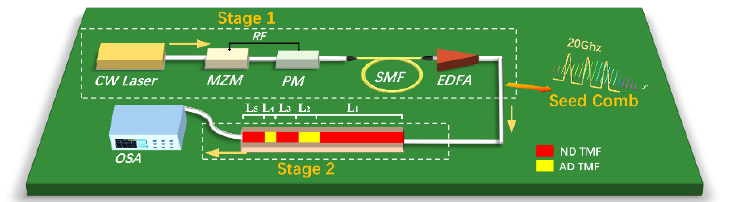
Figure 1. Schematic diagram of a broadband flat OFC generator based on